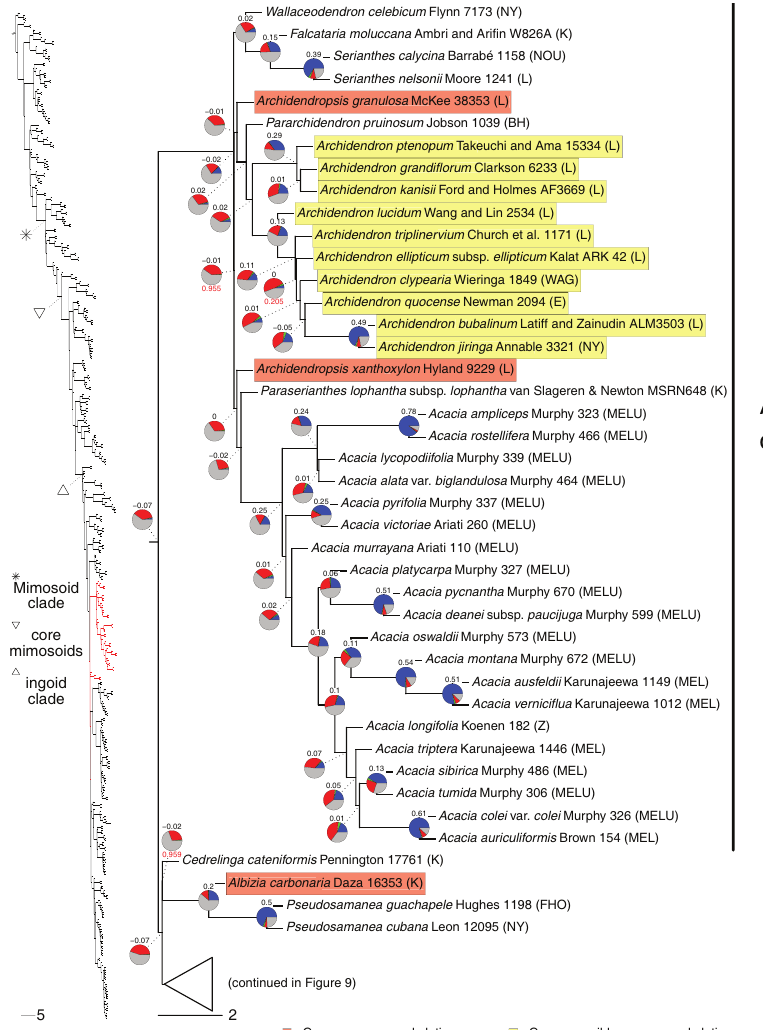
Figure 8. Phylogeny of Caesalpinioideae (continued). See Fig. 2 for